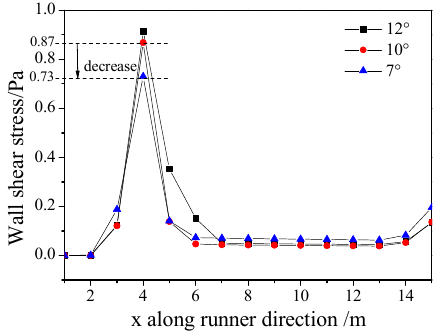
Figure 12. Wall shear stress distribution at different angles of the tap hole on line 2 (cf. Figure 3b).